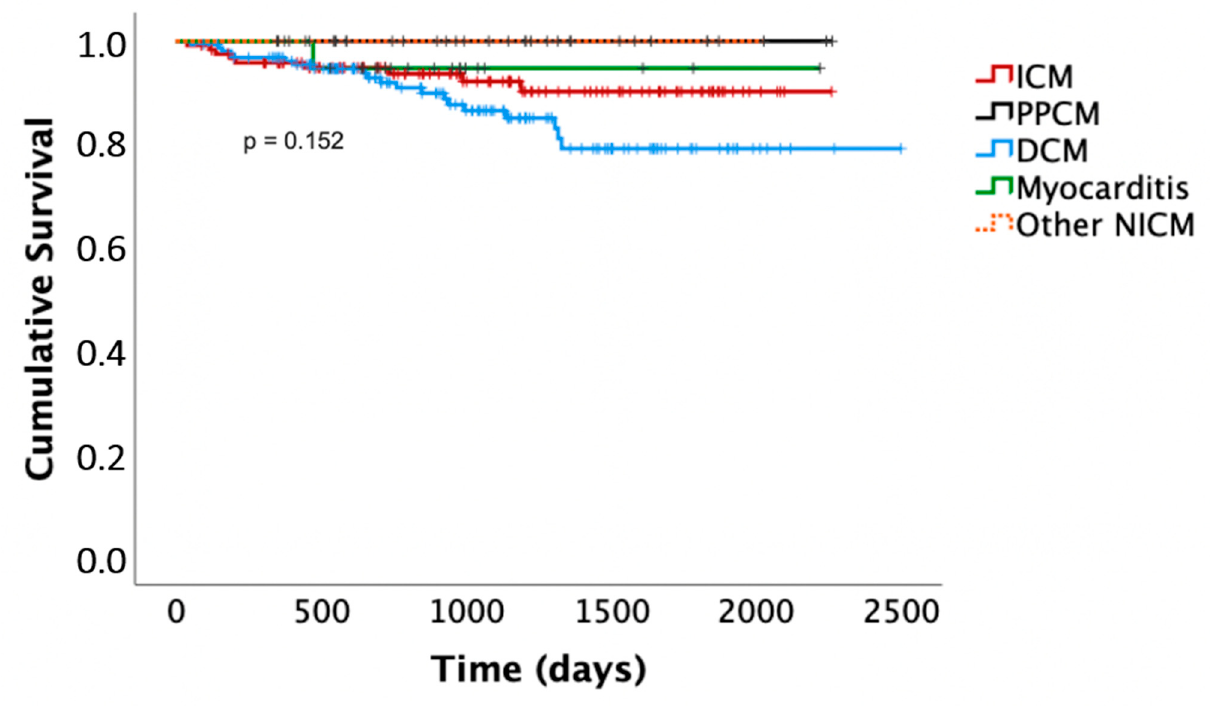
Figure 3. Kaplan–Meier survival curves. ICM, ischemic cardiomyopathy; DCM, dilated cardiomy- opathy; PPCM, peripartum cardiomyopathy; NICM, non-ischemic cardiomyopathy.